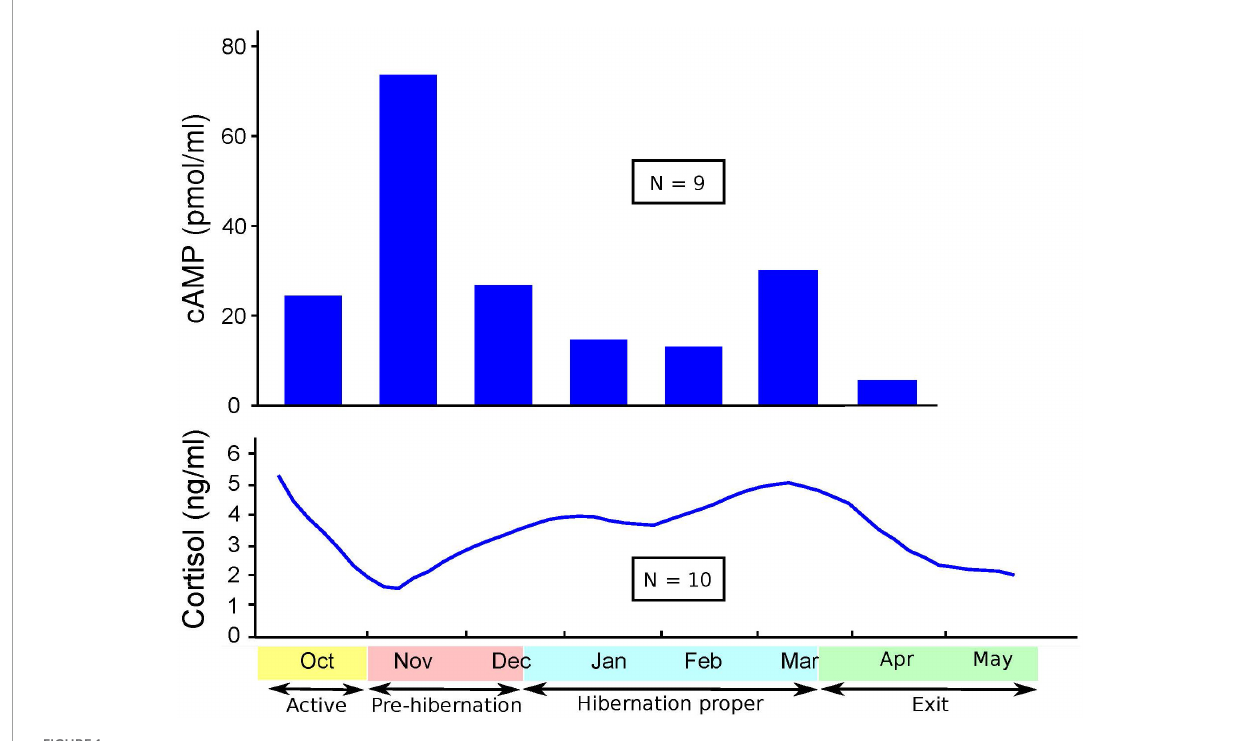
FIGURE1 Levels of cyclic adenosine monophosphate (cAMP) and cortisol over